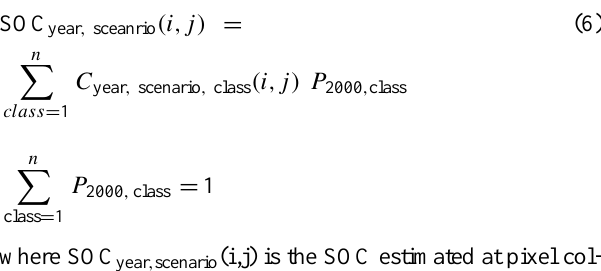
Fig. 2. The “reliability” of the hard decision tree classification re- sults shown in Fig. 1. For each pixel the number of unique classes (maximum 9) that it could be independently classified as over the 30 decision tree classification runs is shown. Pixels reporting a value of 1 were always classified as one particular LCLU type, whereas pix- els reporting values of 5–7 were variously classified into between 5–7 LCLU types. White shows unclassified (water bodies, clouds, cloud shadows, settlement areas, or no Landsat